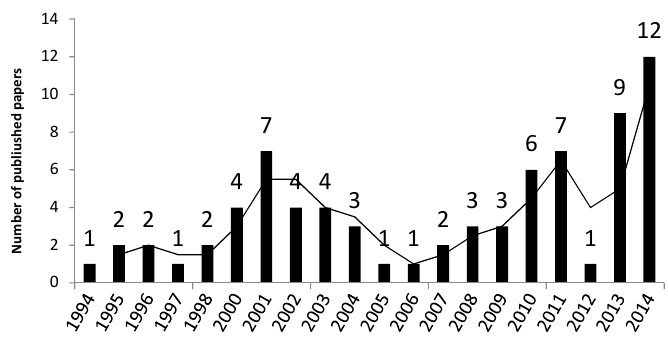
Figure 2. Numbers of studies by year.